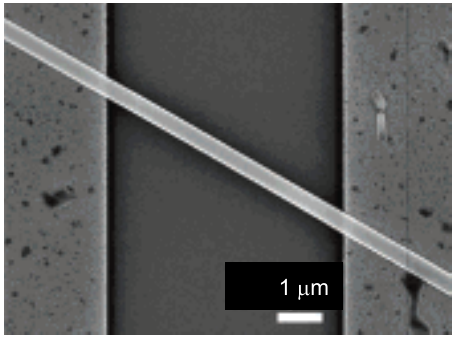
•Cu micro/nano-wire of 2